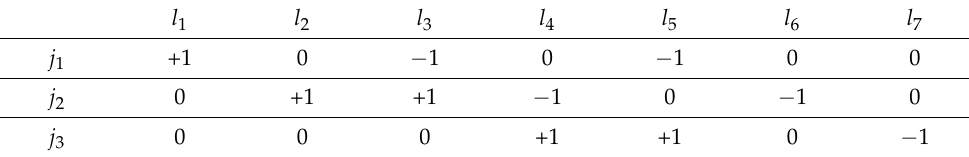
Figure 1. Illustrative network. Table 1. Nodes-links incidence matrix, A , for the illustrative